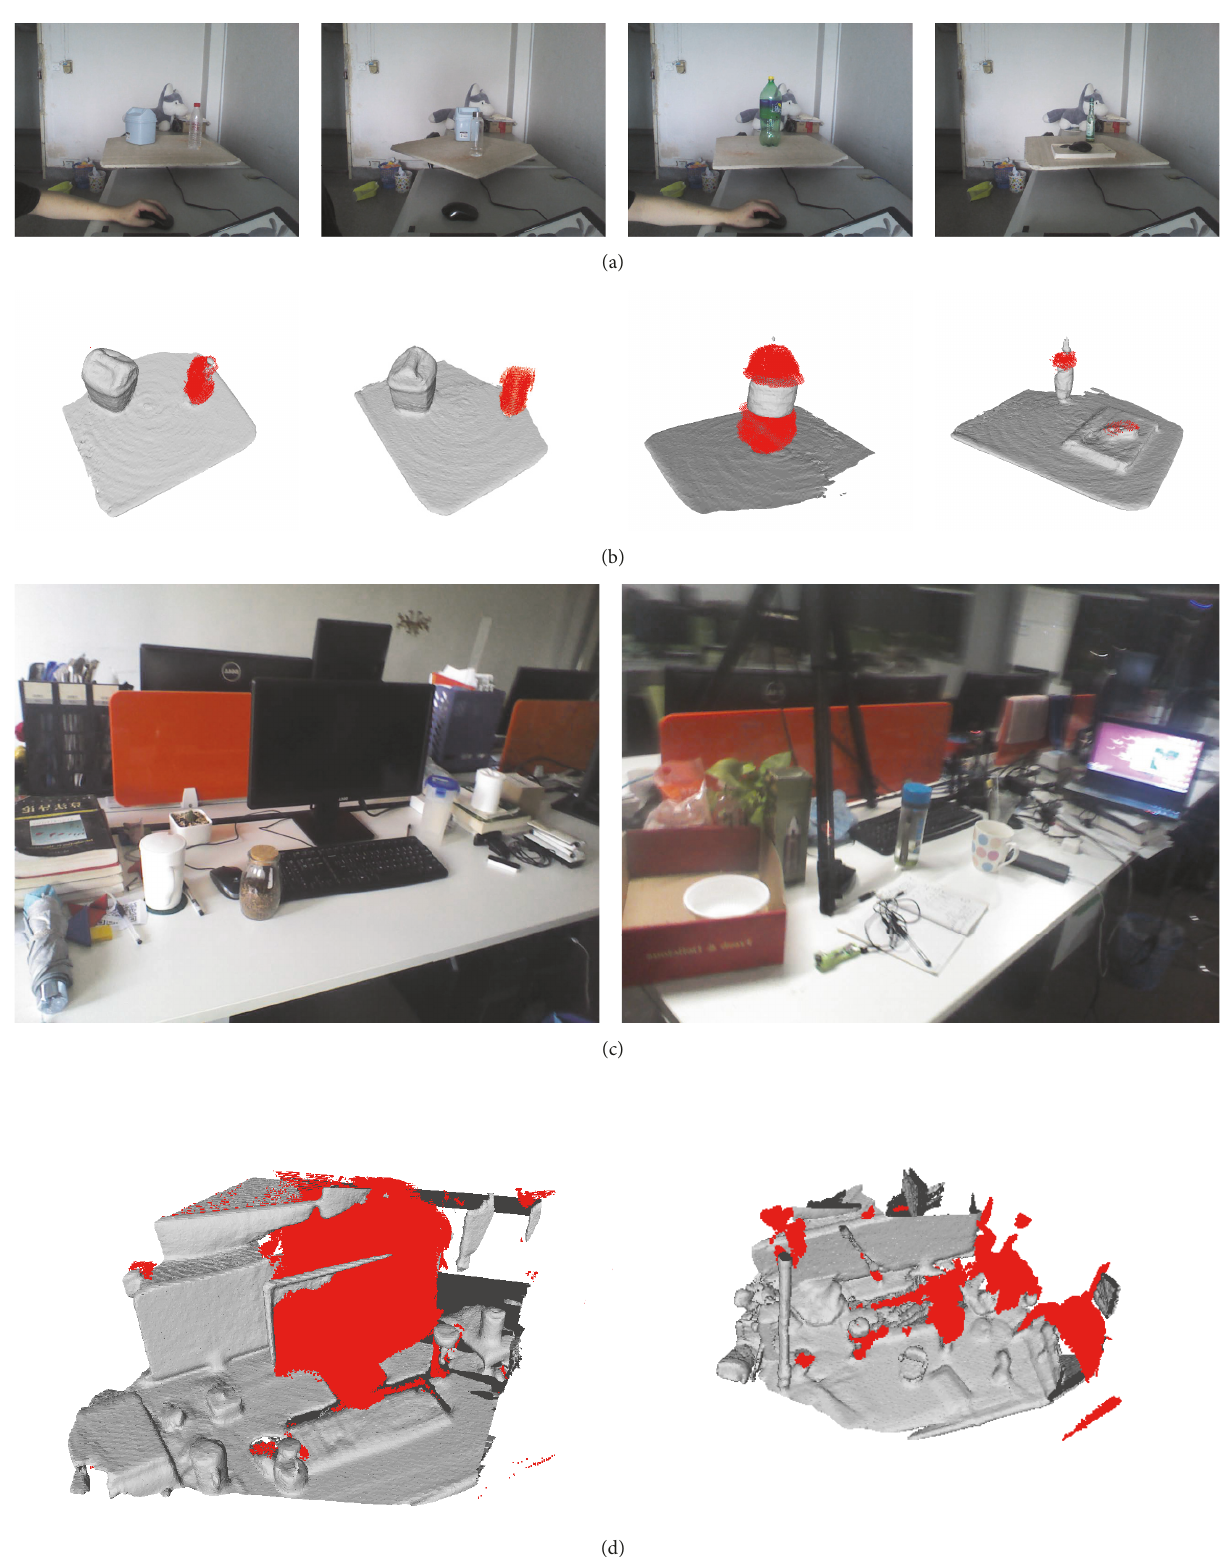
Figure 5: Results on noise region. (a) Color images captured by stationary camera with a rotating platform. (b) The noisy voxels detected by multiple depth images are in red. (c) and (d) show the experimental results done by a moving Kinect; the background is changing in these two